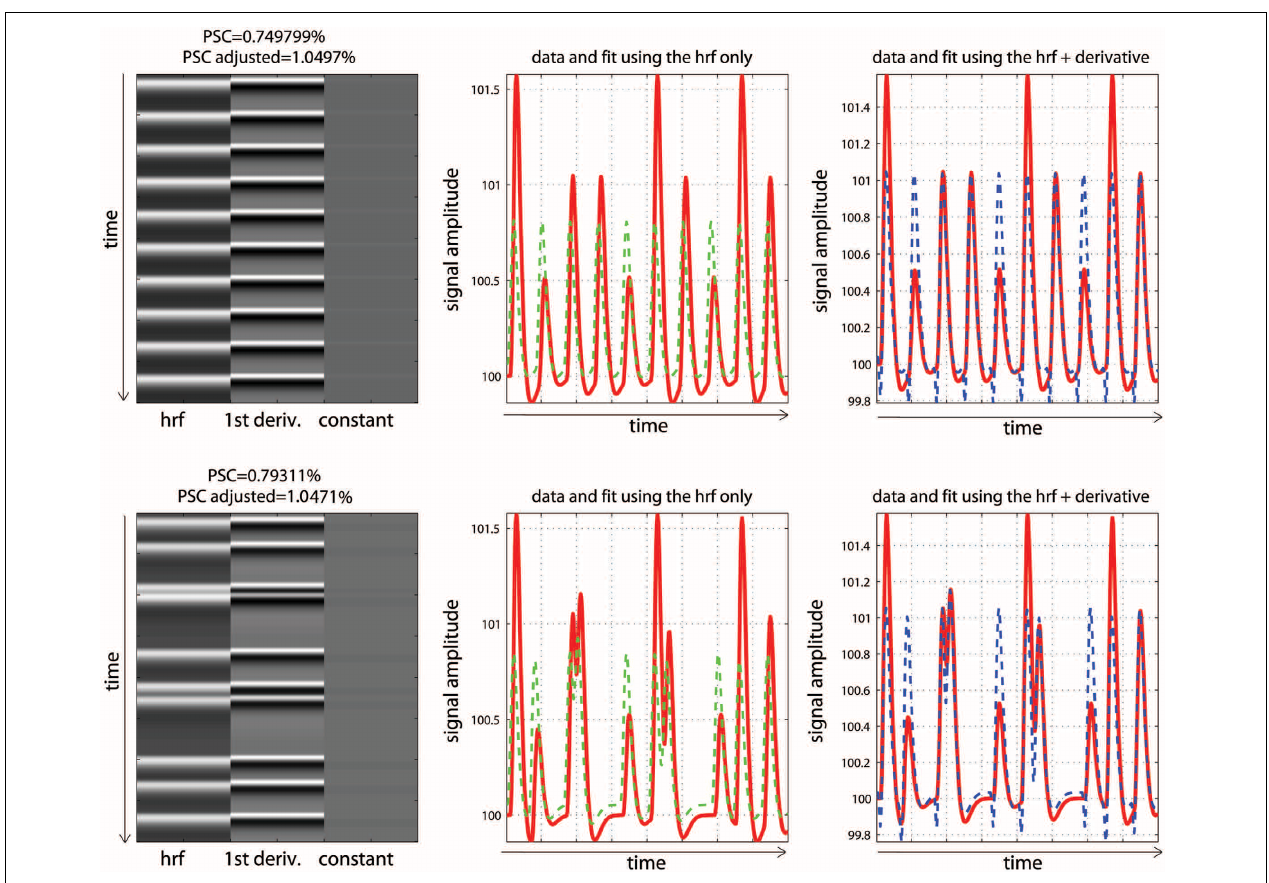
FIGURE 7 | Periodic (top) vs. random (bottom) event related designs with a temporal shift in the data. The fitted data using the hrf only (green) are misaligned with the signal (red), leading to under-estimate